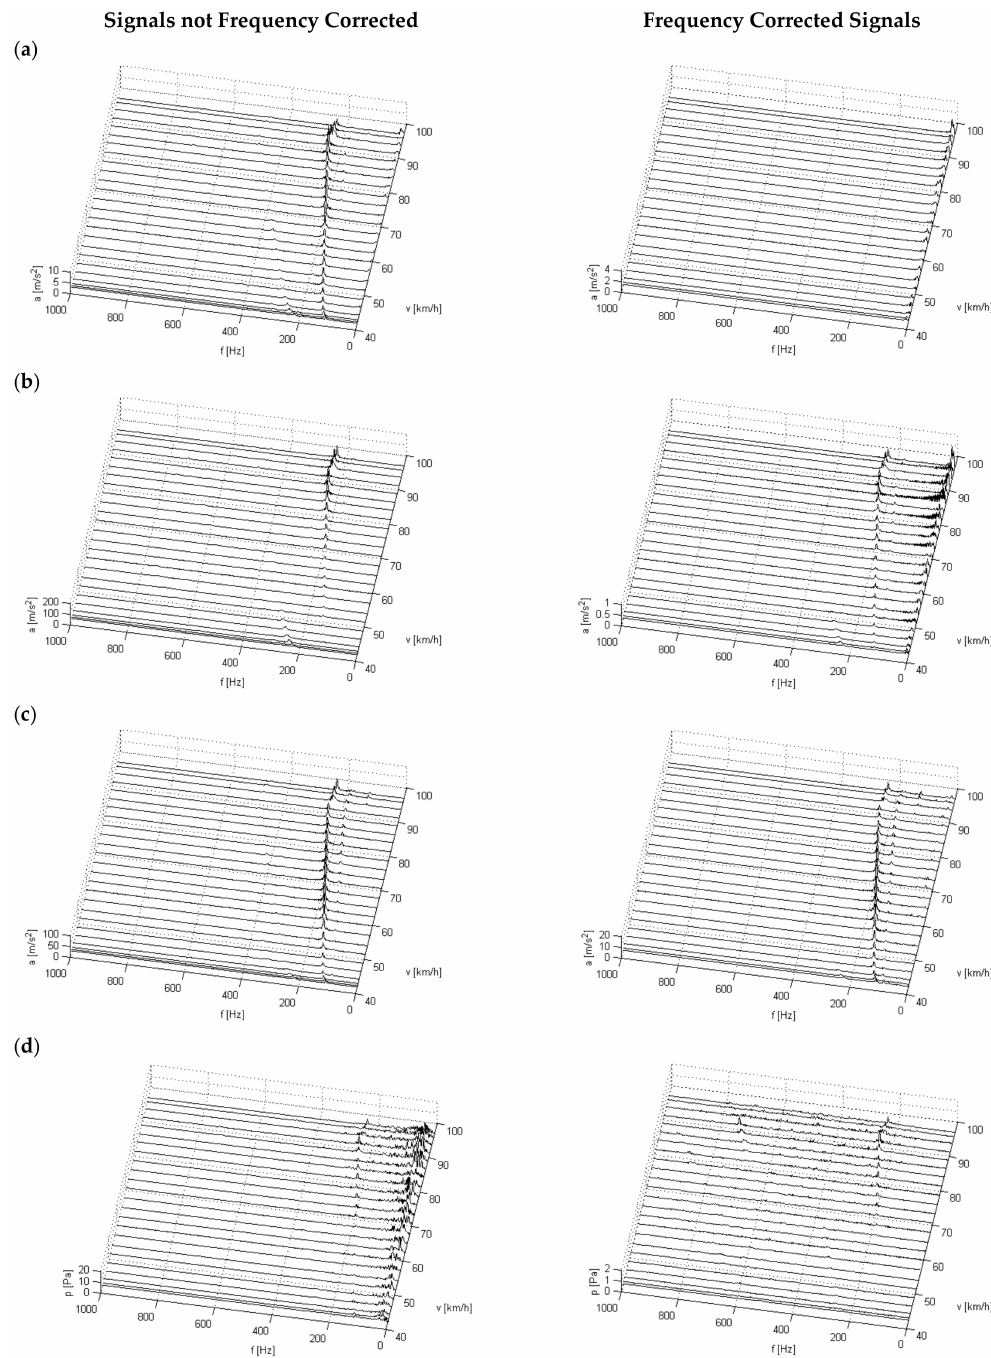
Figure 14. Time-frequency distributions of acceleration of vibration in the Z direction and noise—frequency corrected and not: ( a ) measuring point—seat, ( b ) measuring point—footrest, ( c ) measuring point—handlebars, ( d ) measuring